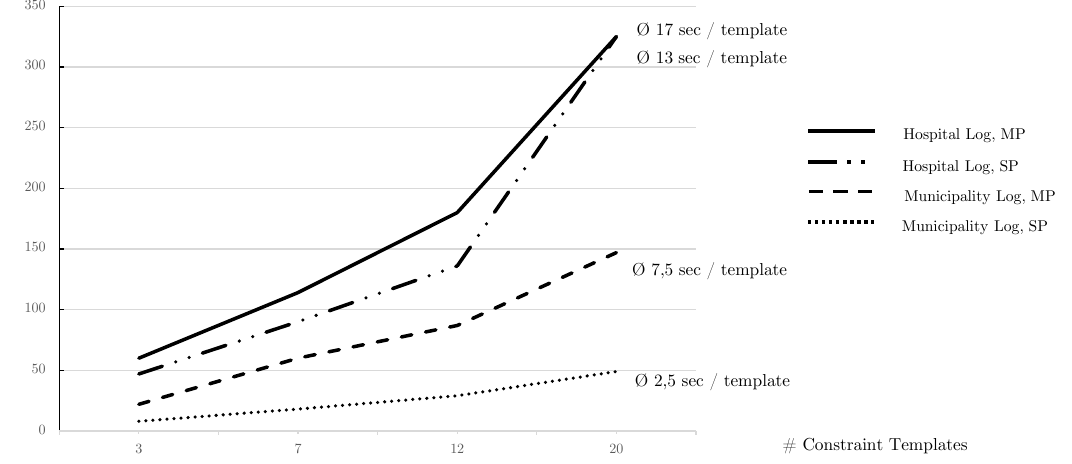
Figure 6. Quantitative analysis of different Log-Files with different